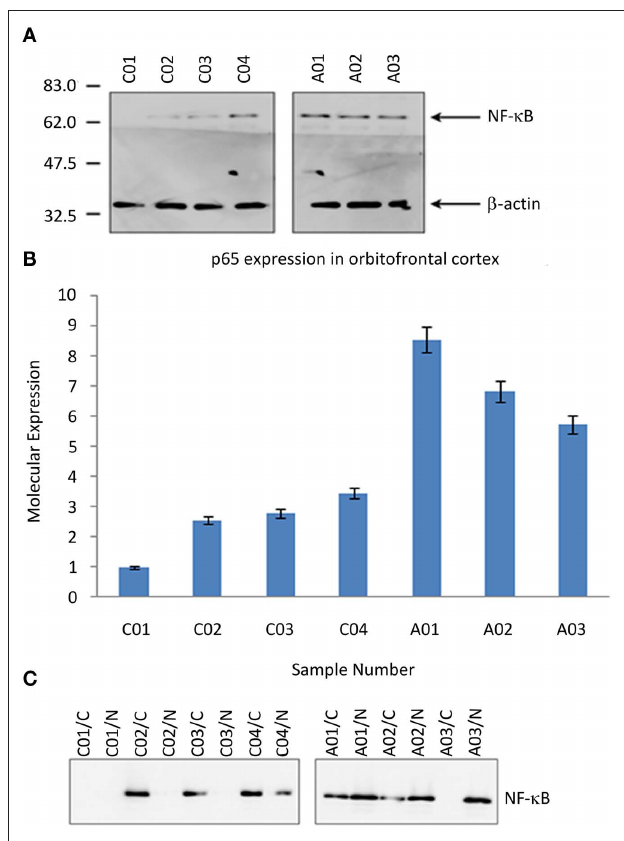
FIgURe 1 | NF- κ B in post-mortem tissue from the orbitofrontal cortex from ASC and control donors. (A) Image of Western blot probed with the anti-NF- κ B p65 and anti- β -actin antibodies (loading control). Molecular mass markers are shown in kDa. (B) Relative expression of NF- κ B p65 subunit, normalized to the lowest value recorded (Study ID C01). (C) Image of fractioned samples probed with anti-NF- κ B p65. Sample IDs suffixed “/N” are the nuclear component, and suffixed “/C” the cytosolic component. Sample IDs prefixed “A” are from ASC donors, prefixed “C” from control donors.